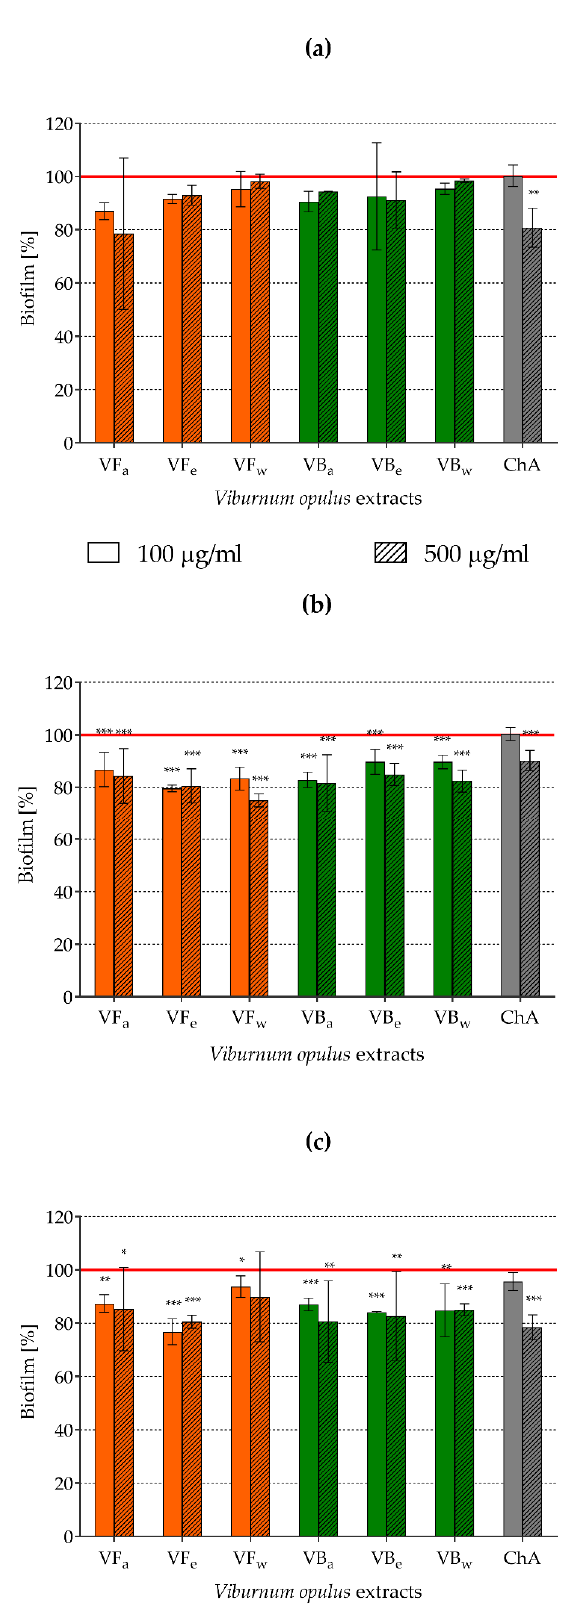
Figure 5. The effects of V. opulus extracts on the ability of staphylococci to form biofilm: ( a ) S. aureus ATCC 29213; ( b ) S. aureus ATCC 43300; ( c ) S. aureus H9; VF— V. opulus fruit extract; VB— V. opulus bark extract; a/e/w—acetonic/ethanolic/water extract; ChA—chlorogenic acid; statistically significant differences compared with the control: * p ≤ 0.05, ** p ≤ 0.01, *** p ≤ 0.001.